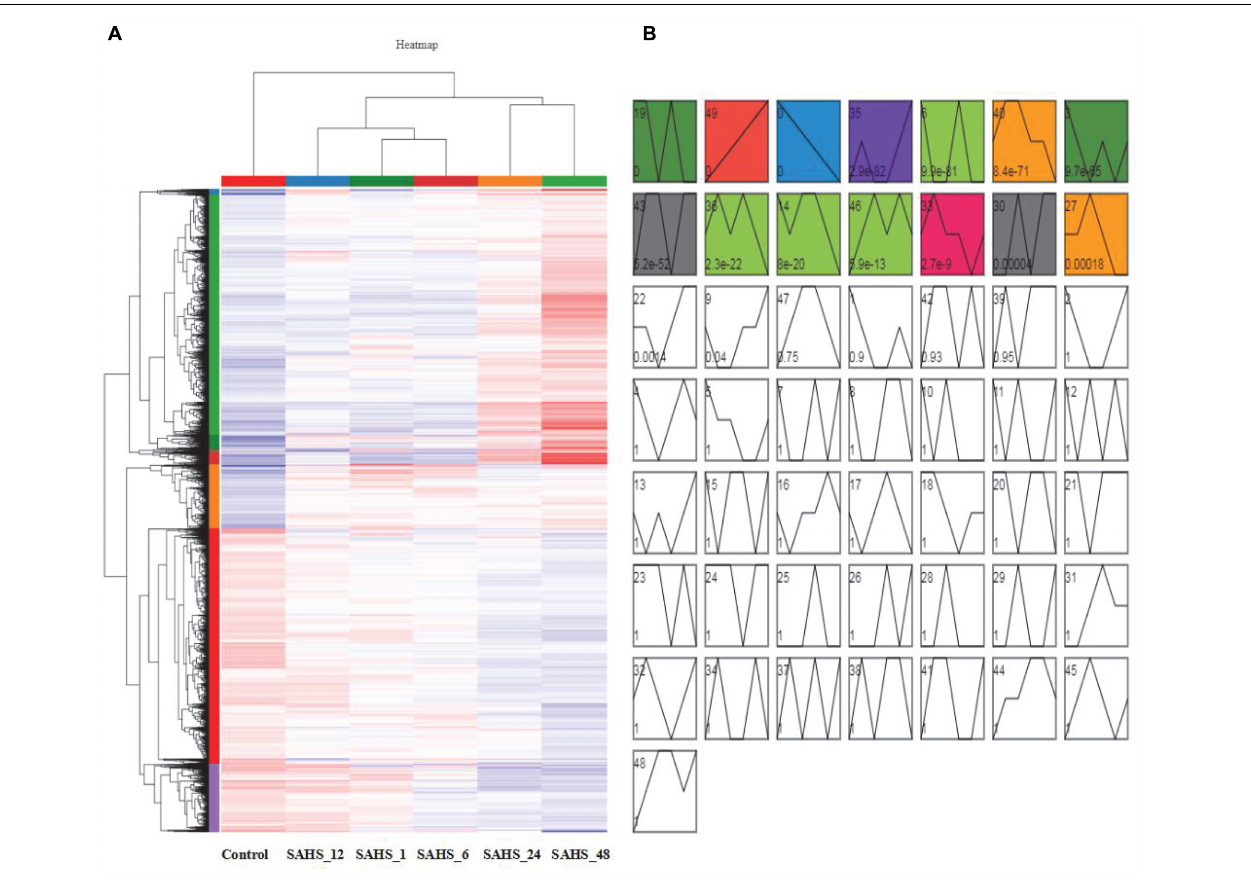
FIGURE 3 | Cluster analysis and gene expression profiling of DEGs. (A) Cluster analysis of the DEGs. The X axis indicates sample type, the Y axis represents relative expression levels, and the red and blue represent upregulation and downregulation. (B) Gene expression profiling of DEGs by STEM analysis. The 14 colored profiles are significant profiles ( p < 0.01), and the P -values in each cluster is shown.